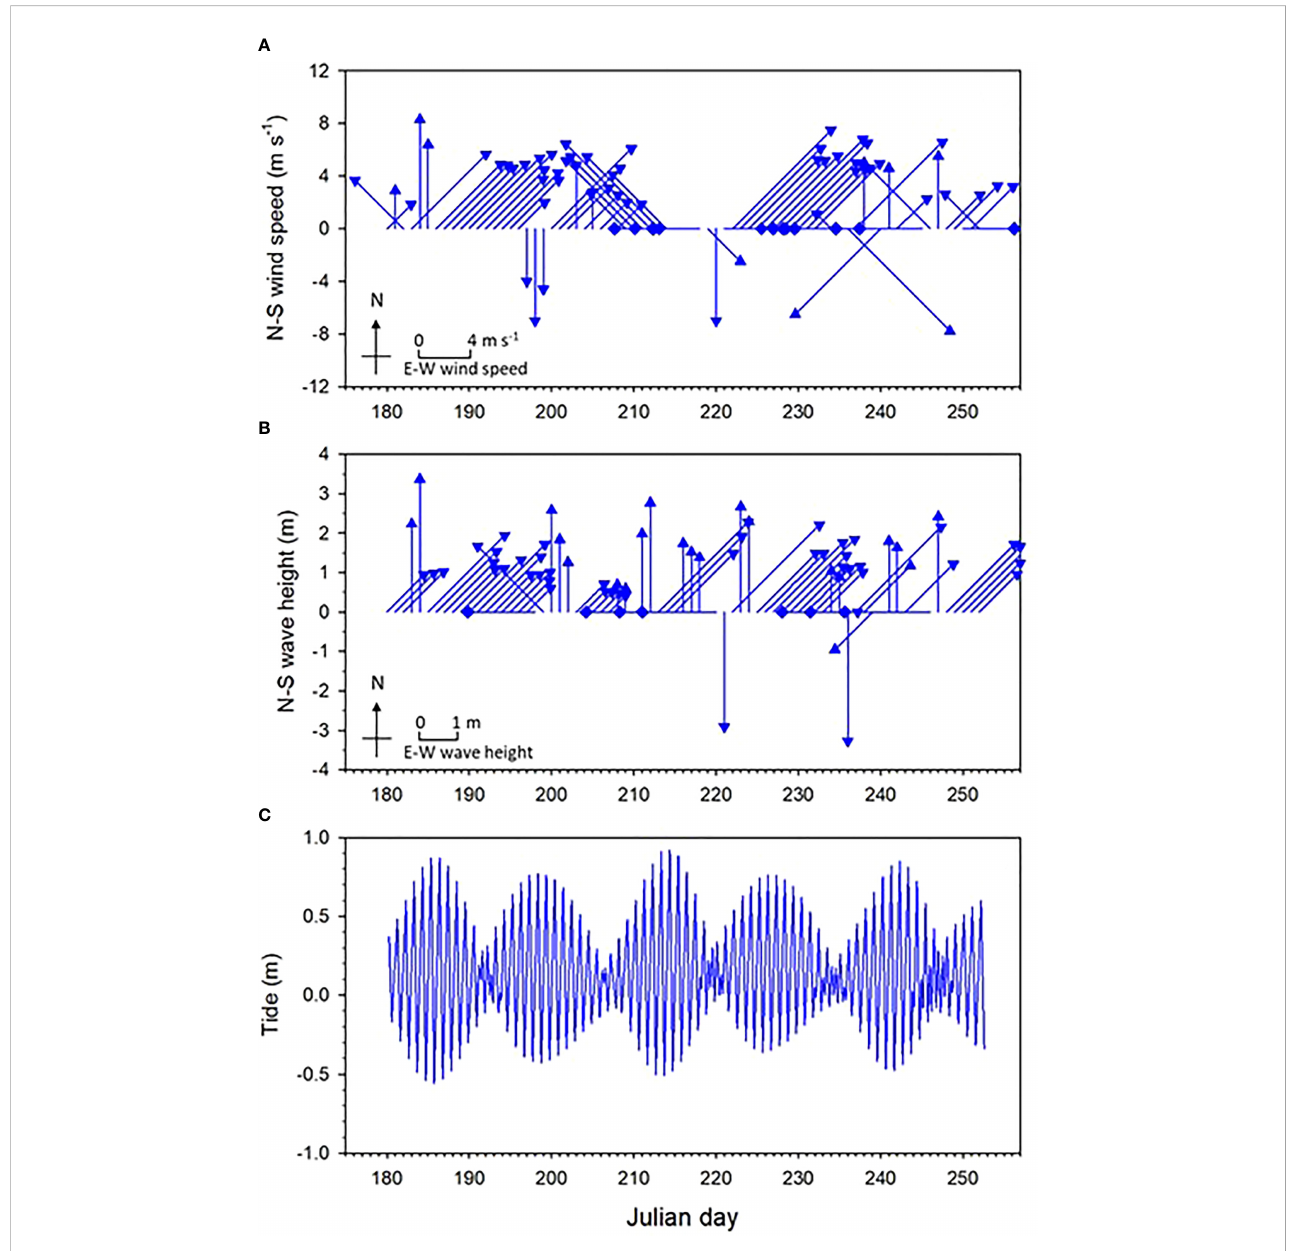
FIGURE 2 Time-series variations in (A) wind, (B) , wave, and (C) tide variation during the study period. Wind and wave are showed in eight